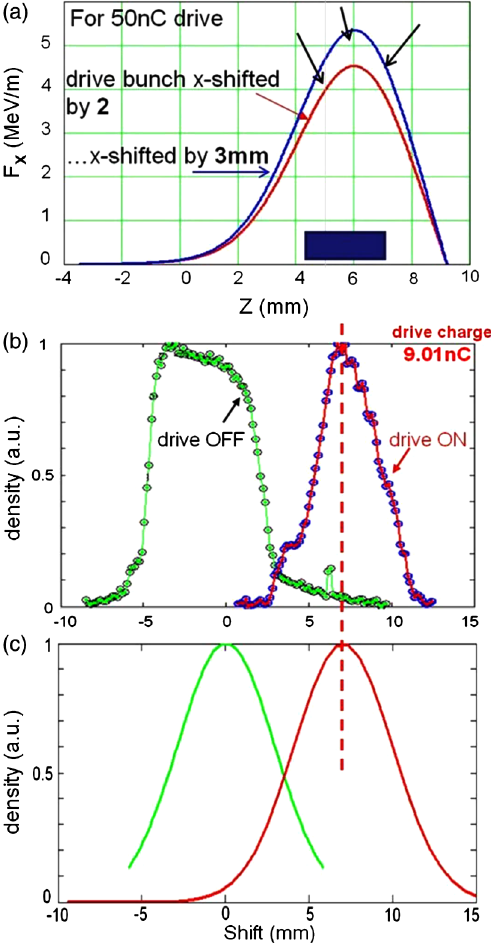
FIG. 16. (a) Simulations of F x for the test channel. (b) Typical bunch horizontal distribution (observed in 80% of shots, nor- malized to 1) when the delay was 10.7 mm. (c) Predicted changes in horizontal distribution [case #2 in Tables V and VI with the drive bunch being shifted off the center of its respective channel by 2 mm (toward the test